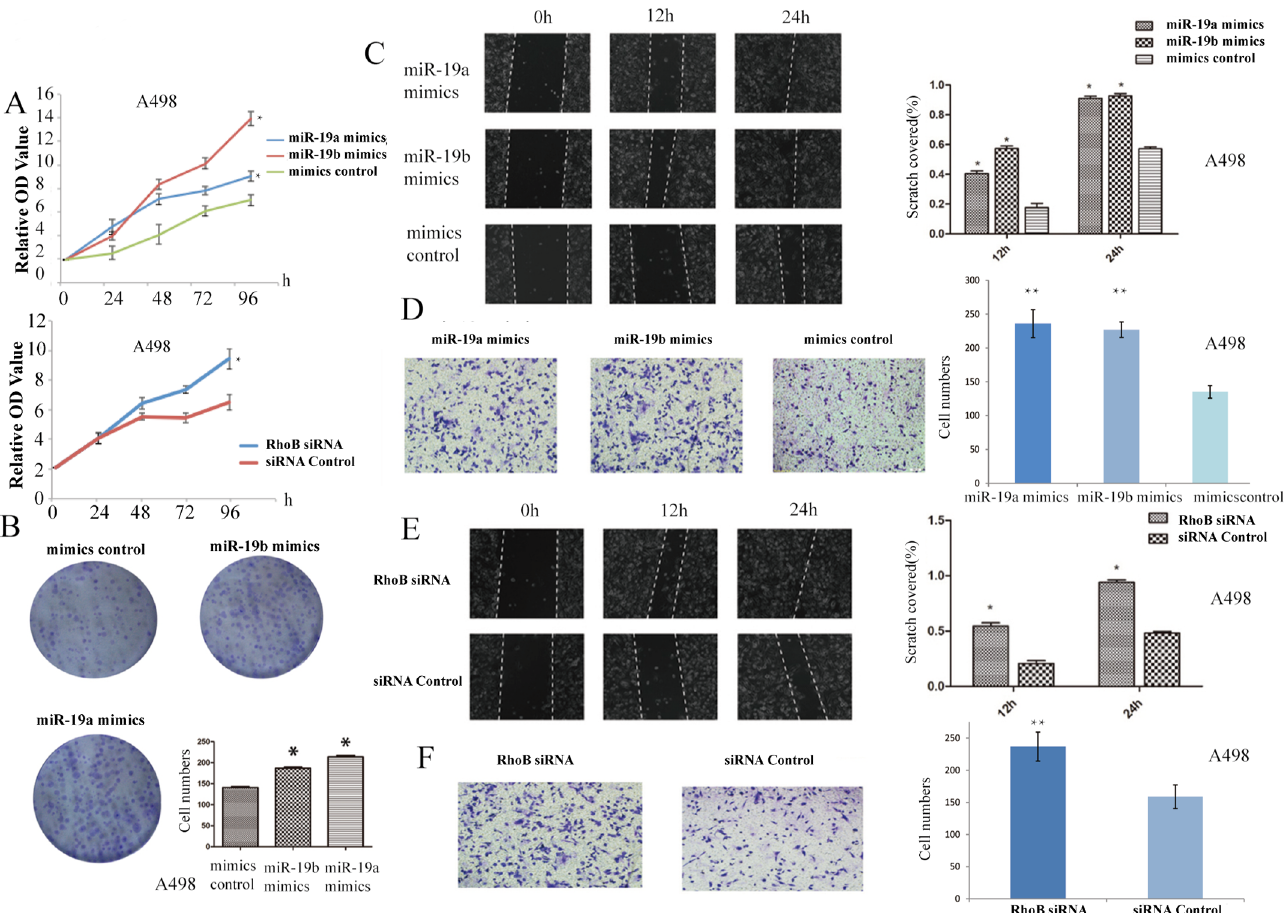
Fig 3. Overexpression of miR-19a and miR-19b or RhoB knockdown show similar phenotypes in promoting the growth, migration and mobility of ccRCC cells. (A) MTS results showing the promotion potential of miR-19a and miR-19b mimics overexpression or RhoB knockdown on the proliferation of A498 cells. (B) Representative images and quantification show the clonogenic plating efficacy of A498 cells overexpressing miR-19a and miR-19b mimics. (C and D) Representative images (right) and quantification (left) of wound healing assay (C) and transwell assay (D) showing the potential effects of the overexpression of miR-19a and miR-19b mimics on the migration and invasiveness of the cells. Control oligo was included as a negative control. (E and F) Representative images (right) and quantification (left) of wound healing assay (E) and transwell assay (F) showing the potential effects of RhoB knockdown on the migration and invasiveness of the cells. Control siRNA was included as a negative control. The data are representative of three independent experiments performed in triplicate. (cid:3) Significant differences from control oligo-transfected cells (P < 0.05).